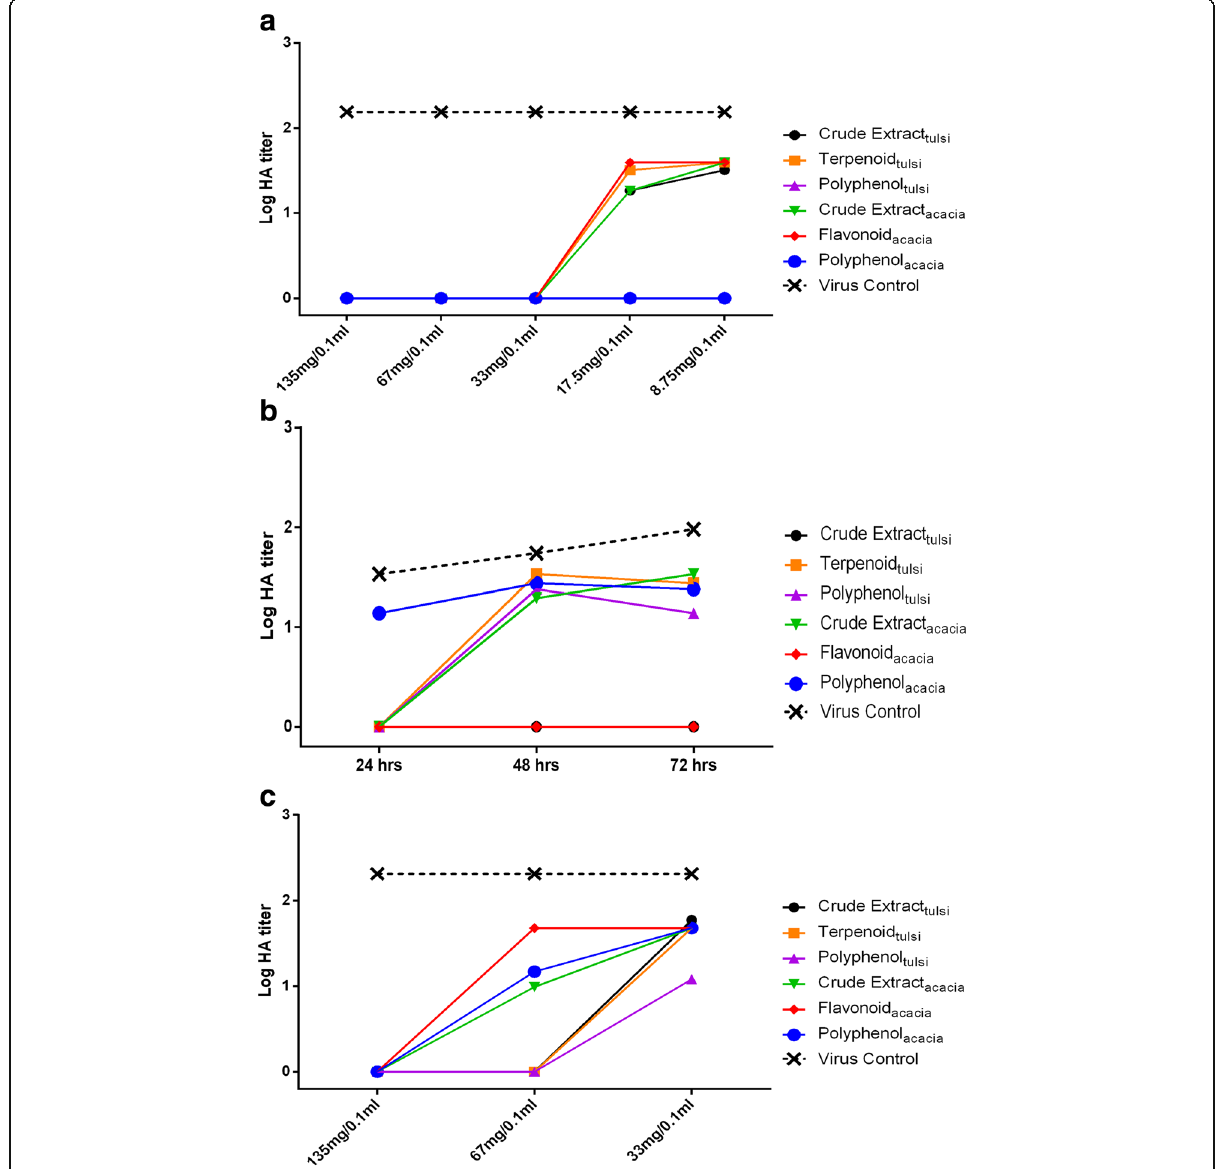
Fig. 2 Measurement of antiviral activity of O. sanctum and A. arabica leave extracts against H9N2 virus using HA assay. a Dose-dependent virucidal activity; b Time-dependent therapeutic activity; c Dose-dependent prophylactic activity. The virus control group included 500 EID 50 /0.1 ml of H9N2 virus incubated with 0.1 ml PBS for 2 h at 37 °C. The HA titer were expressed as log HA